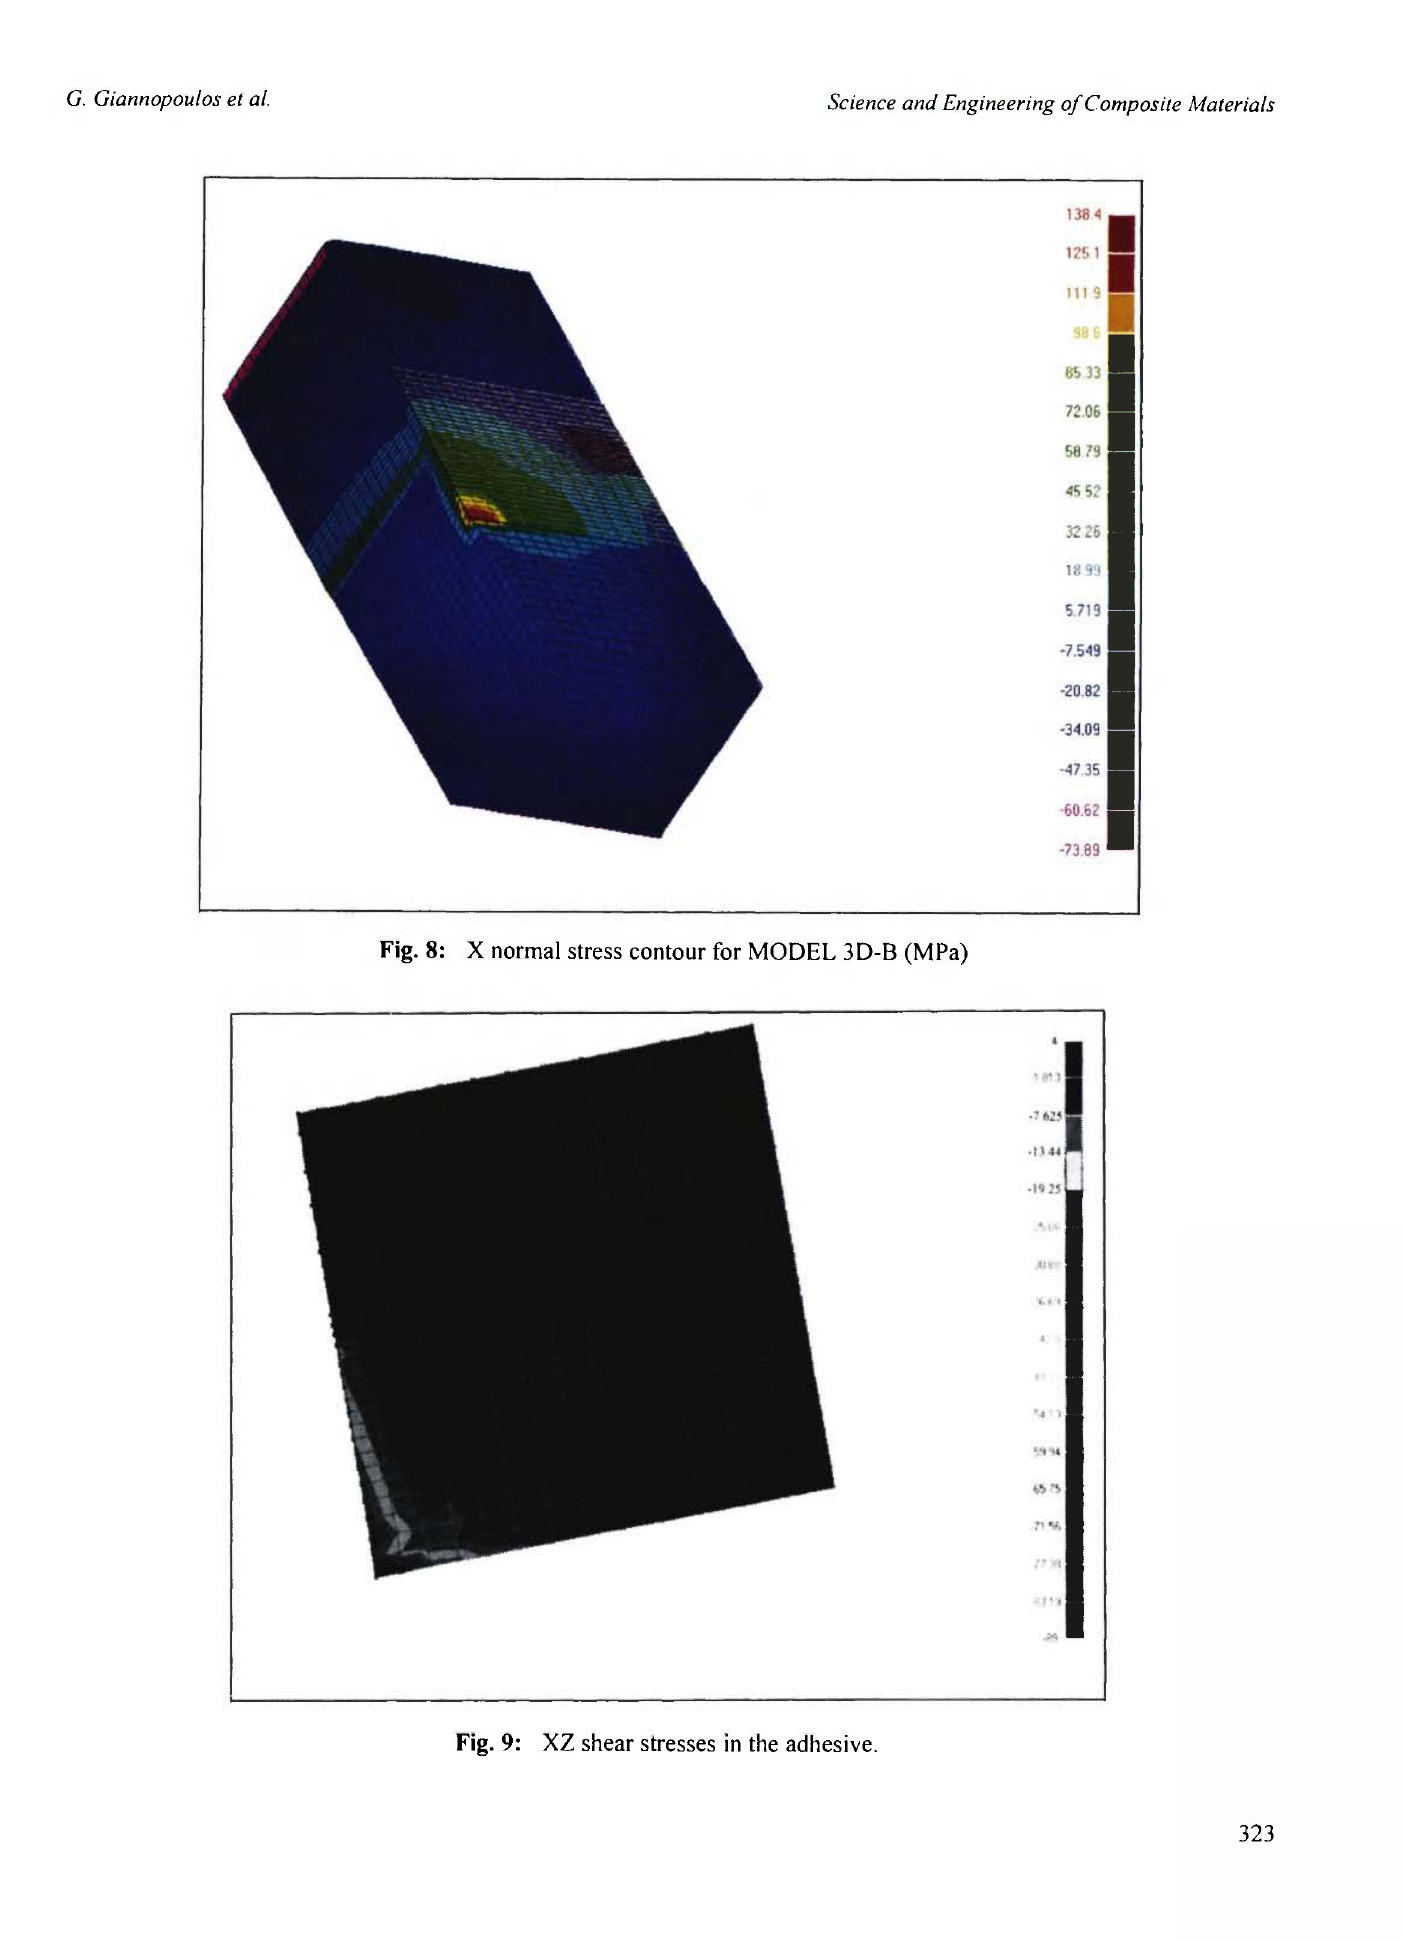
Fig. 9: XZ shear stresses in the